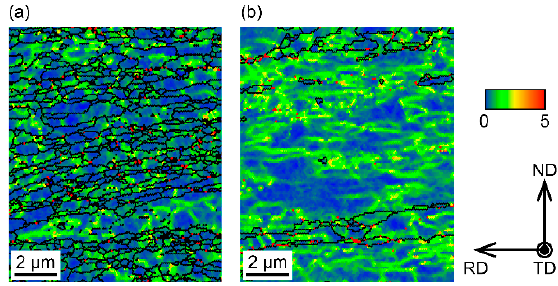
Figure 5. KAM maps of the rolled specimen of ( a ) fine grains and ( b ) coarse grains.